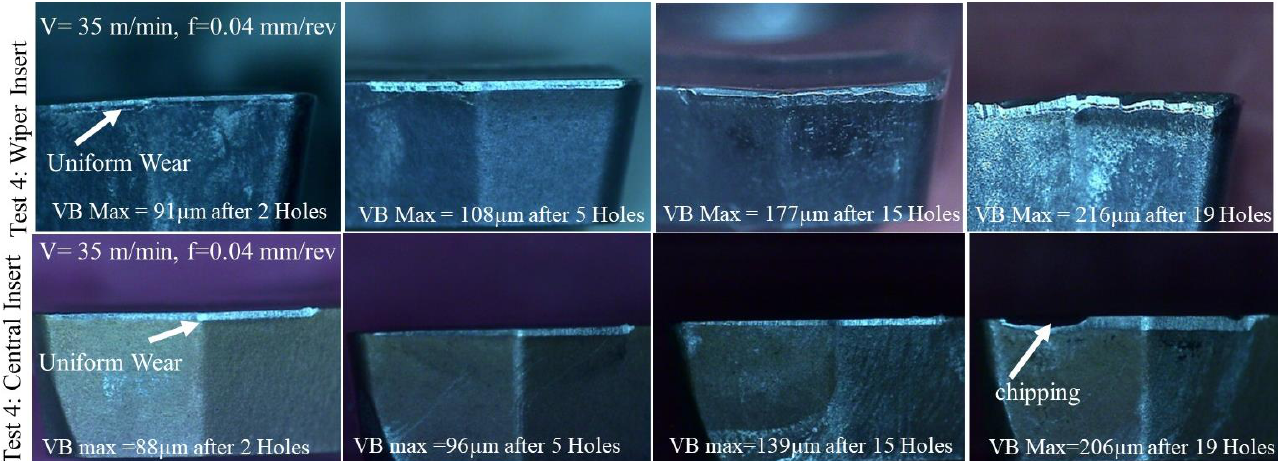
Figure 13. Wear evolution of central and wiper inserts for Test 4.